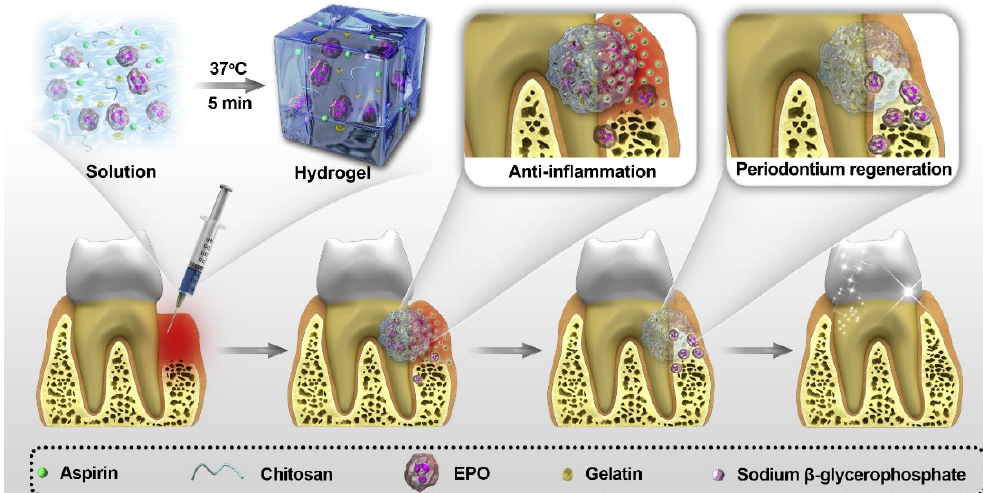
Figure 4. Schematic illustration of the preparation and application of the CS/ β -GP/gelatin hydrogels. Reprinted with permission from Ref. [112] Copyright 2019 Elsevier.